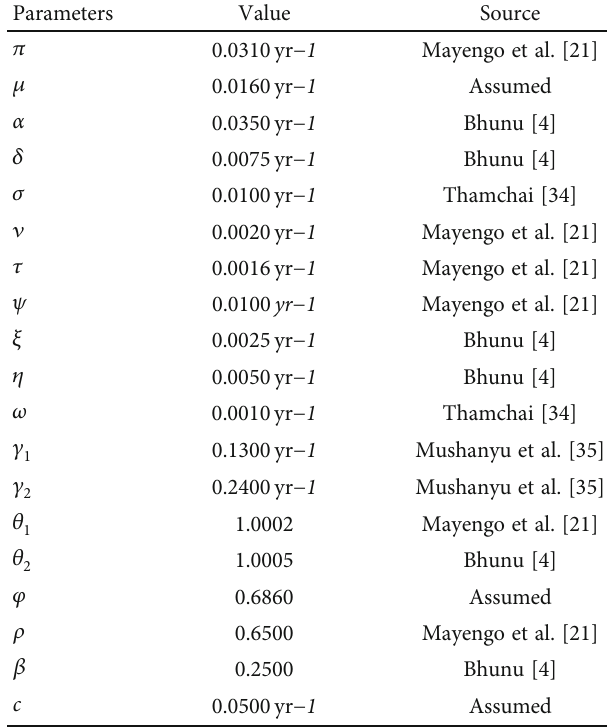
Table 1: Description of the variables and parameters for model